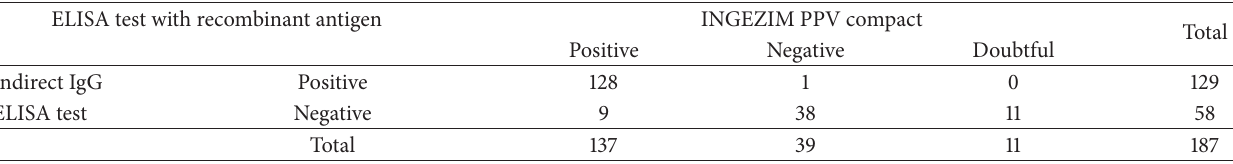
Table 1: Summary of the concordance of results obtained with the newly developed indirect IgG ELISA and with the commercial INGEZIM test.